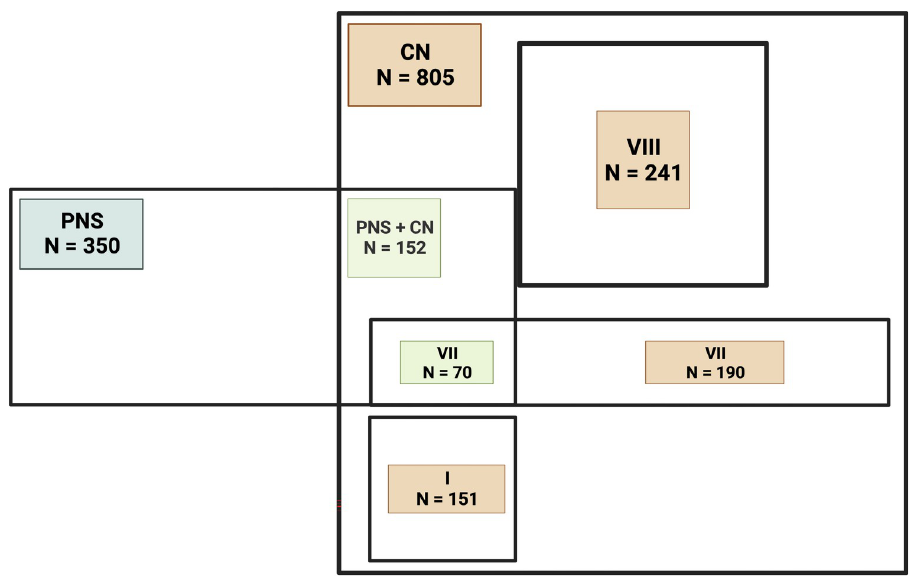
Fig 2. Peripheral nervous system involvement; PNS–peripheral nervous system, PNS+CN–peripheral nervous system and cranial nerves, I–olfactory nerve, VII–facial nerve, VIII–vestibulo-cochlear